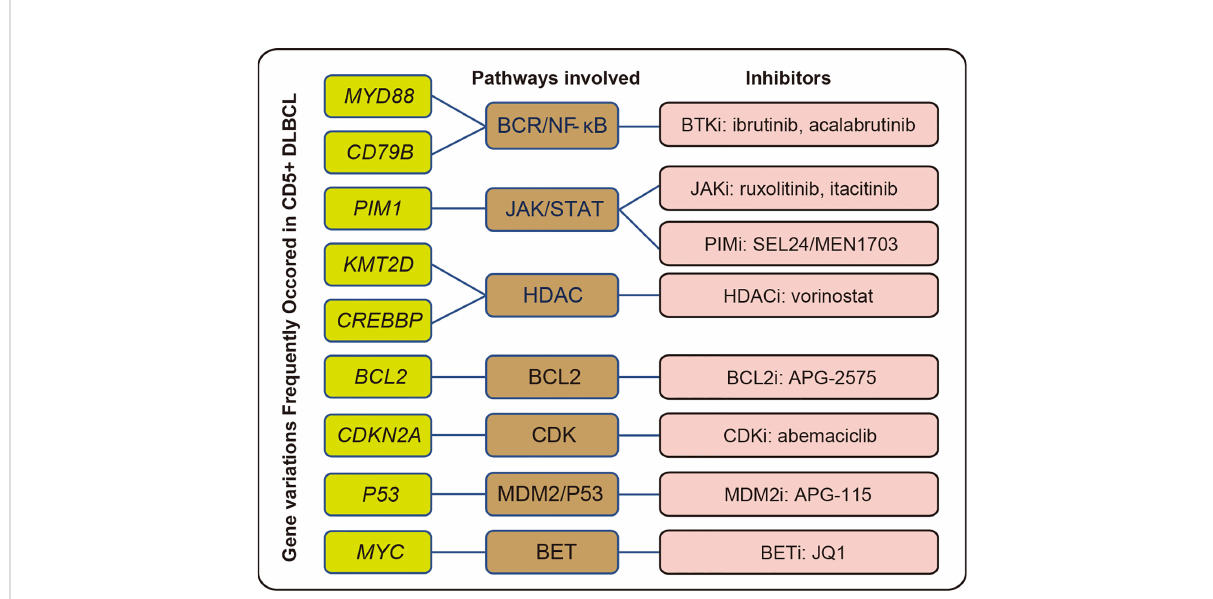
FIGURE 7 Summary of common gene variations with potentially related pathways and inhibitors in CD5+